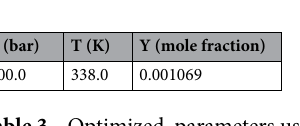
Table 3. Optimized parameters using the GPR method.